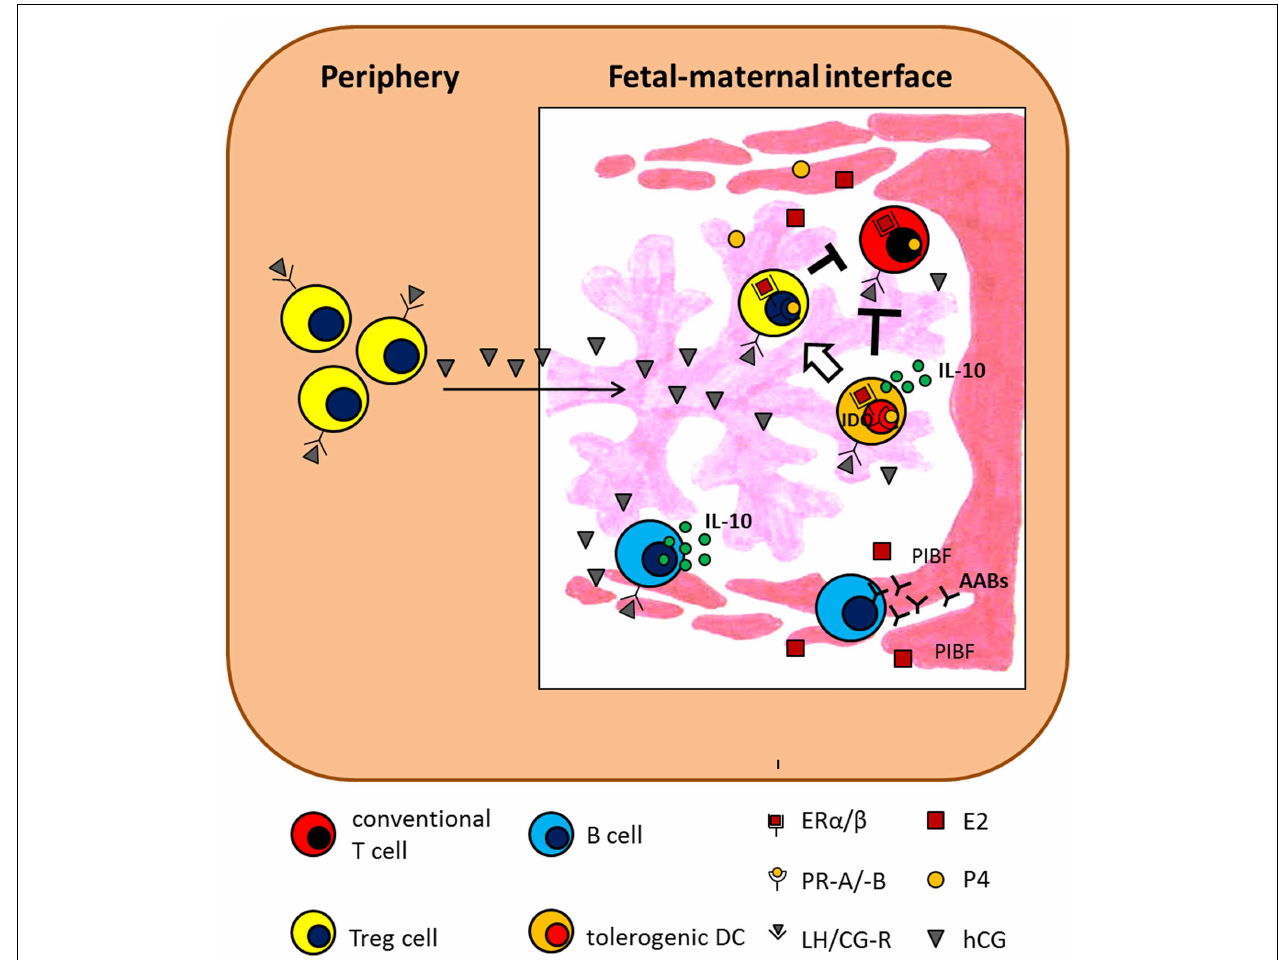
antibodies; ER, estrogen receptor; IDO, indoleamine 2,3-dioxygenase; IL-10, interleukin-10; LH/CG-R, luteinizing hormone/chorionic gonadotropin receptor; PIBF, progesterone-induced blocking factor; PR, progesterone receptor.